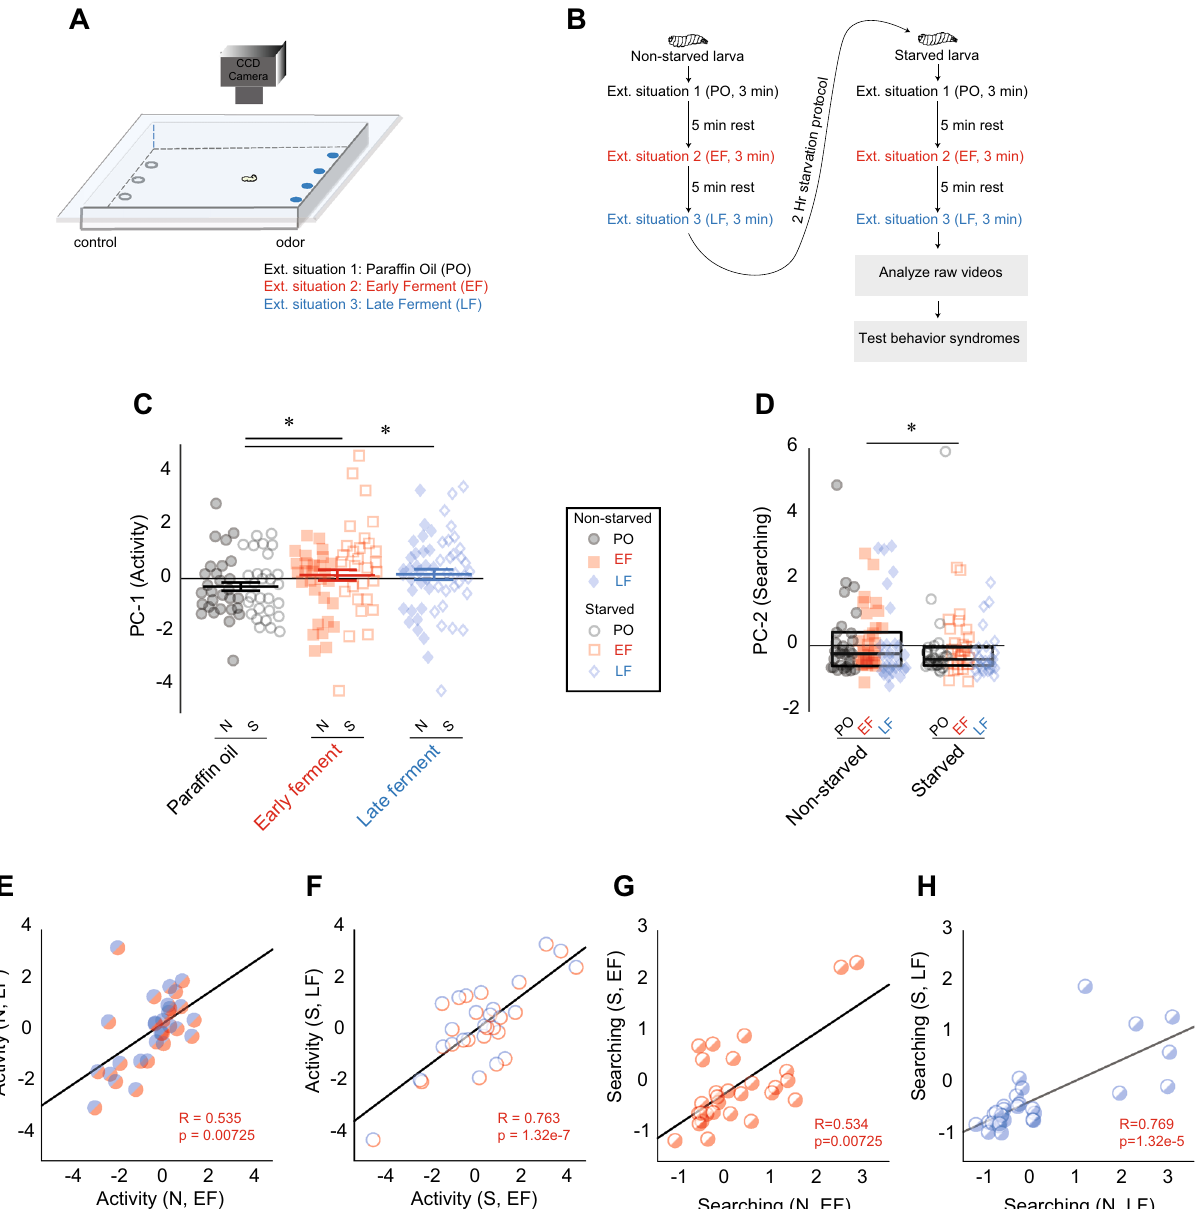
Figure 2. Experiment 2: Effect of internal and external situations. ( A ) A single non-starved larva is sequentially exposed to three situations: situation 1 (PO: no odor); situation 2 (EF: early ferment odor); situation 3 (LF: late ferment odor). The larva is then starved for 2 h and again exposed to the same situations. Larval movements are recorded by a CCD camera, n = 30. Adapted from Mathew et al. 25 . ( B ) A schematic of the paradigm is provided on the right. ( C ) Average activity measure for non-starved (filled shapes) and starved (empty shapes) larvae in situation 1 (black circles), situation 2 (red squares), and situation 3 (blue diamonds). *p = 0.048 (PO vs EF) and *p = 0.0328 (PO vs LF), ANOVA. ( D ) Average searching measure for the same set of larvae. *p = 0.005, non- parametric ANOVA. ( E–H ) Correlation examples: ( E) between the activity of non-starved larvae in situation 2 and its activity in situation 3. p < 0.025, Pearson’s correlation, n = 28; ( F ) between the activity of starved larvae in situation 2 and its activity in situation 3. p < 0.0001, Pearson’s correlation, n = 28; ( G ) between searching of larvae in situation 2 when non-starved and its searching in the same situation when starved. p < 0.025, Spearman’s correlation, n = 28; ( H ) between ‘searching’ of larvae in situation 3 when non-starved and its ‘searching’ in the same situation when starved. p < 0.025, Spearman’s correlation, n =